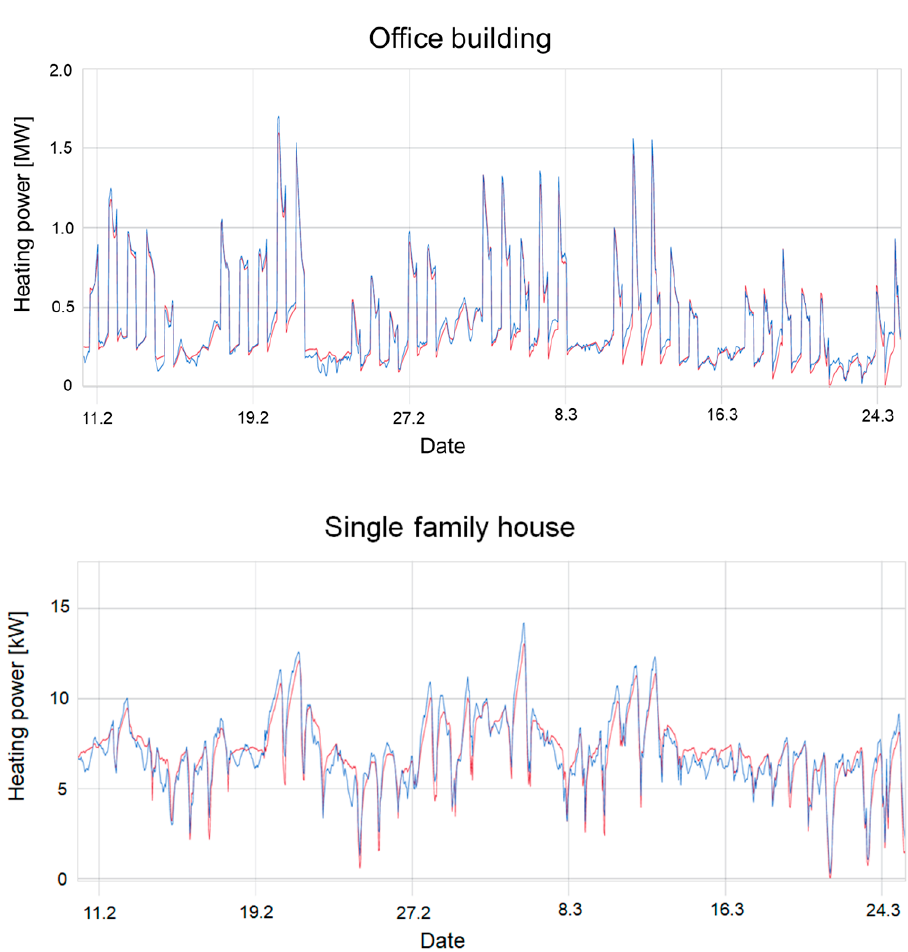
Figure 3. Six week examples of measured (red) and forecast (blue) heating load for different building types (apartment, office, single family home).